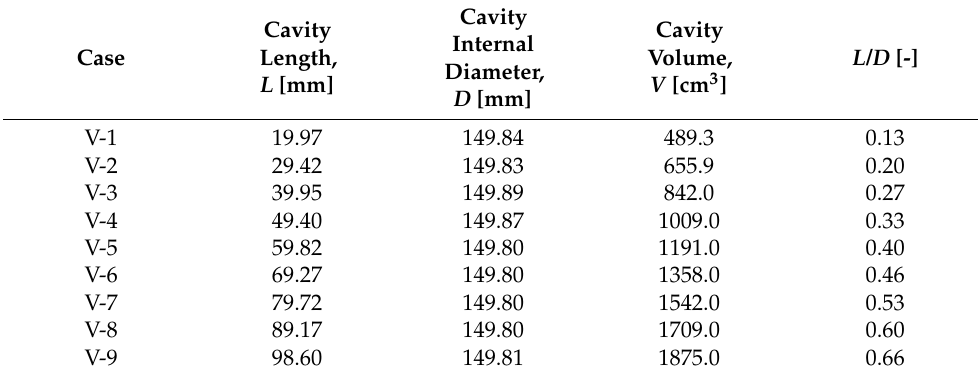
Table 1. Parameters of the cavity used in the SJ actuator